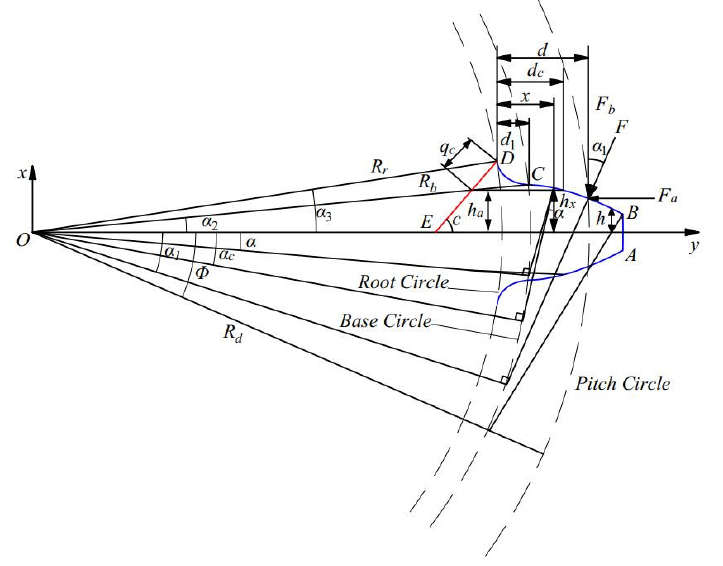
Figure 3. Geometric diagram of gear teeth with cracks.